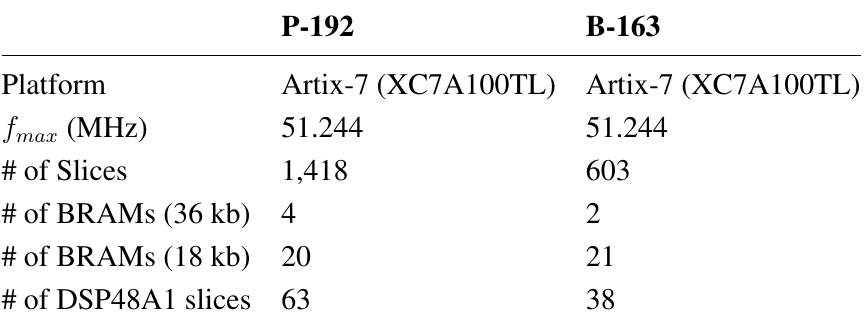
Table 5. PAR results of the two proposed accelerators.